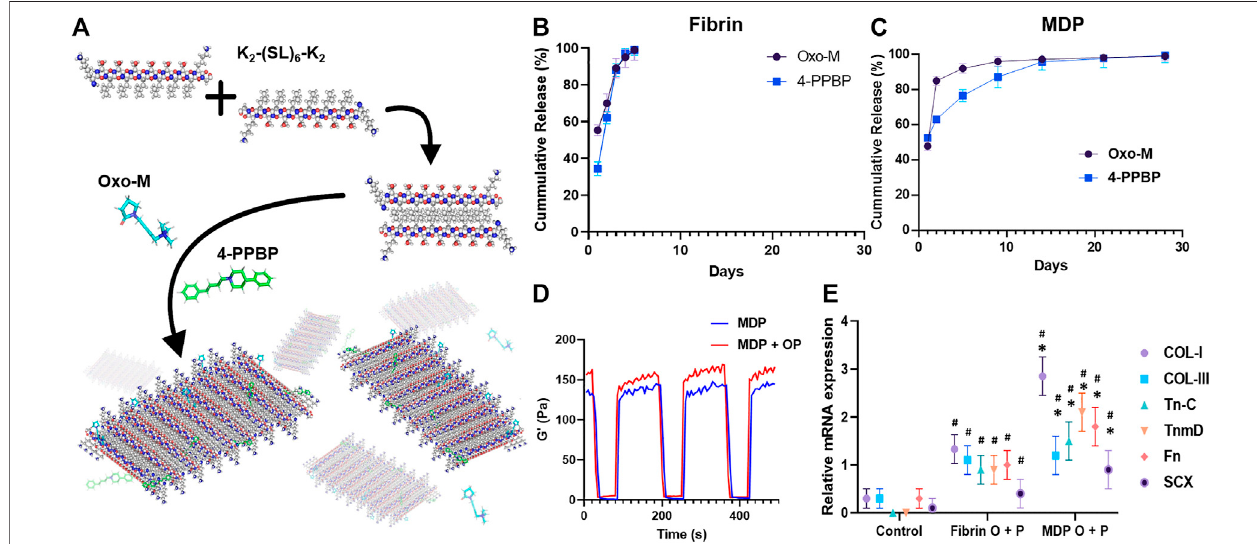
FIGURE 1 | Multidomain peptide (MDP) hydrogel as a controlled delivery vehicle for Oxo-M and 4-PPBP. MDP self-assembles supra-molecularly into nano fi bers that encapsulate drugs while maintaining shear thinning and shear recovery properties (A) . This allows for facile aspiration and delivery as depots into tissue sites for the localizedreleaseofsmallmoleculedrugsfrombiodegradablepeptidescaffolds.Oxo-Mand4-PPBPloadedin fi bringelwerefullyreleasedby3,4 days (B) ,whereasthey showed sustained release from MDP hydrogel up to 25 days (C) . Tenogenic gene expressions were signi fi cantly higher in TSCs cultured under Transwell ® inserts with fi brin and MDP hydrogel releasing Oxo-M and 4-PPBP (C) . Dynamic storage moduli of MDP and MDP + OP hydrogels under repeated strain cycles (1% strain and 100% strain), showing a recovery of viscoelastic properties within 10 s even after repeated strain cycles (D) . Oxo-M and 4-PPBP release from MDP hydrogel resulted in signi fi cantlyhighergeneexpressionsascomparedtowhatwasreleasedfrom fi brin (E) (n=5pergroup;*:p < 0.001compared to fi bringroup; # :p < 0.001comparedto